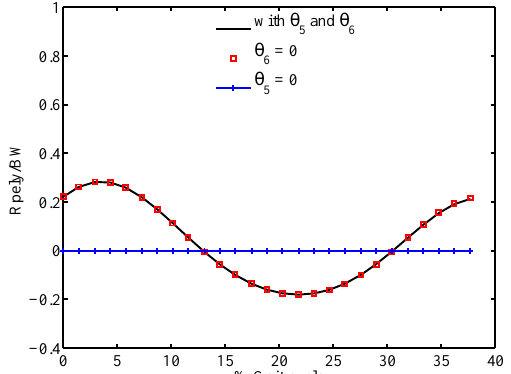
Figure 10. Contributions of pelvis DOF – θ 5 and θ 6 to GRFy in SS phase expressed as a fraction of body weight with AFROS. The results from the model with FROS are similar. (Gait cycle starts at toe-off of the other leg, that is, at the beginning of SS.)